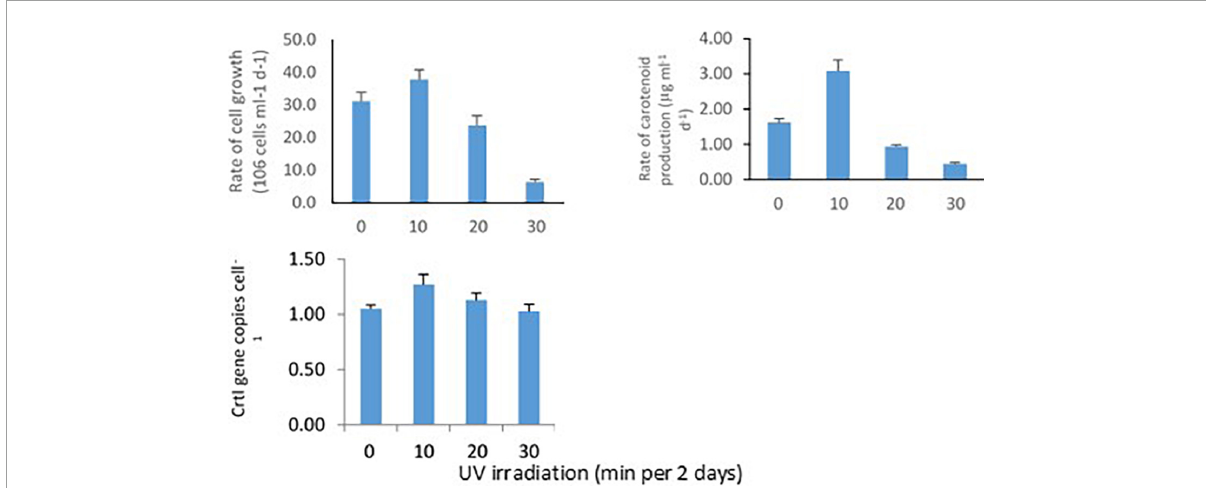
FIGURE3 Effect of UV irradiation on cellular activities of Methylobacter sp N39. The cellular activities were rates of carotenoid biosynthesis, growth rate, and carotenoid biosynthesis gene (CrtI) copy number. Methylobacter sp N39 was grown in ammonium mineral salt broth. Broth was exposed to UV irradiation for 0, 10, 20, and 30 min every 2 days. After exposure broth was re-incubated allowing cells to grow and biosynthesize carotenoid. The process of exposure was repeated at 2 days interval for 10 days. Cell numbers (top left) and carotenoid (top right) concentration were estimated at 2 days interval. Rates were estimated as slope of values over incubation period. After completion of incubation period (10 days), DNA was extracted from broth to quantify carotenoid biosynthesis gene, CrtI by real-time PCR using SYBR green chemistry (bottom left) . X -axis represents UV irradiation (min in 2 days). Y -axis represents different parameters. Each data point represents arithmetic mean and standard deviation as error bar of three replicated